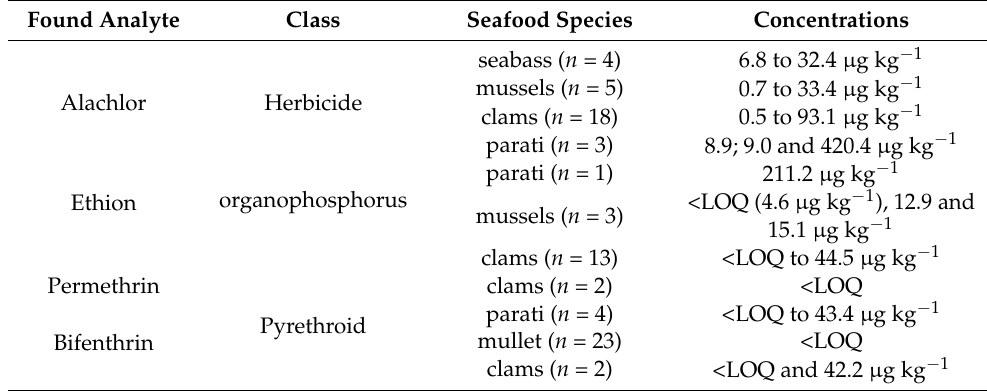
Table 7. Concentrations of analytes found in the analyzed samples ( µ g kg − 1 dw). Found